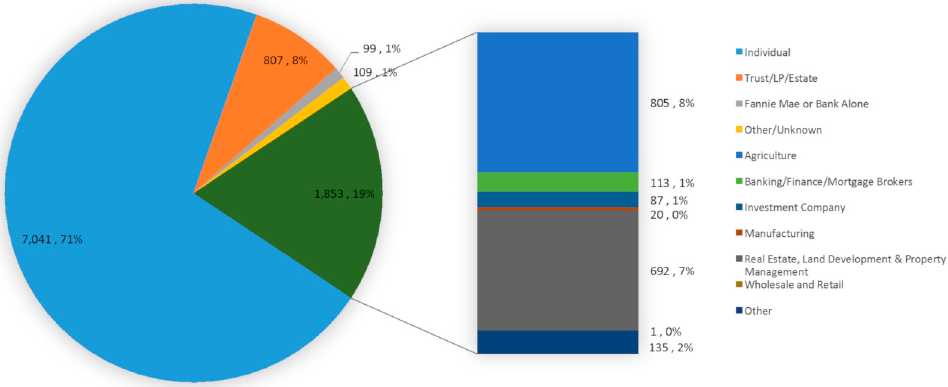
Figure 5. Buyer types, by number and